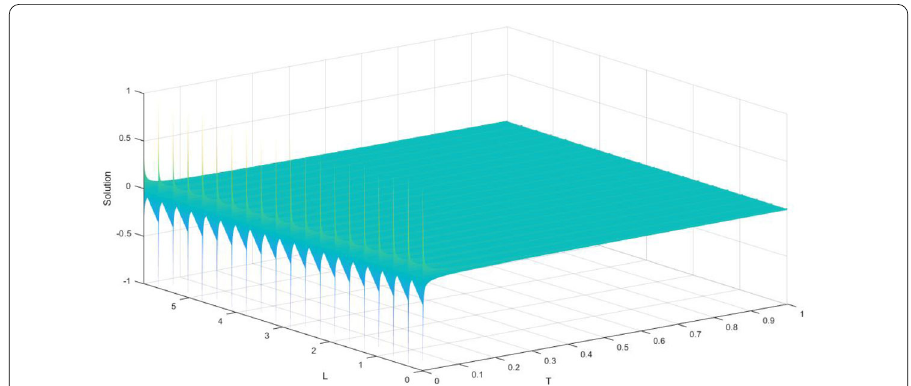
Figure 1 The dynamic behavior of solution for α = 0.5